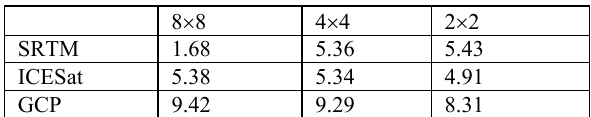
Figure 1. Image coverage of the selected data. The yellow region is TanDEM-X image, the green region is Gaofen-3 Table 2. TanDEM-X DEM accuracy assessed using SRTM, image. While the black rectangle is the selected experimental ICESat and area.